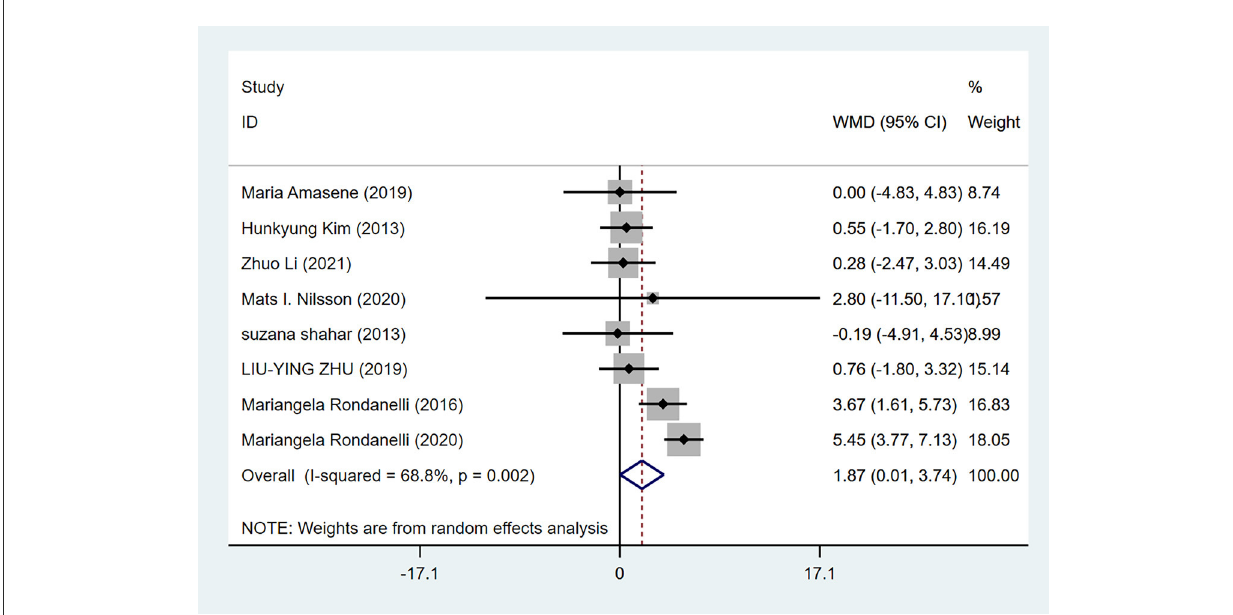
FIGURE2 Forest plot for grip strength of resistance training combined with nutritional supplementation vs. resistance training alone. Overall estimates were obtained from forest plots of the meta-analysis using the random-effects model. Diamond icons and horizontal bars represent the overall estimate and 95% CI. WMD, weighted mean difference; CI, confidence